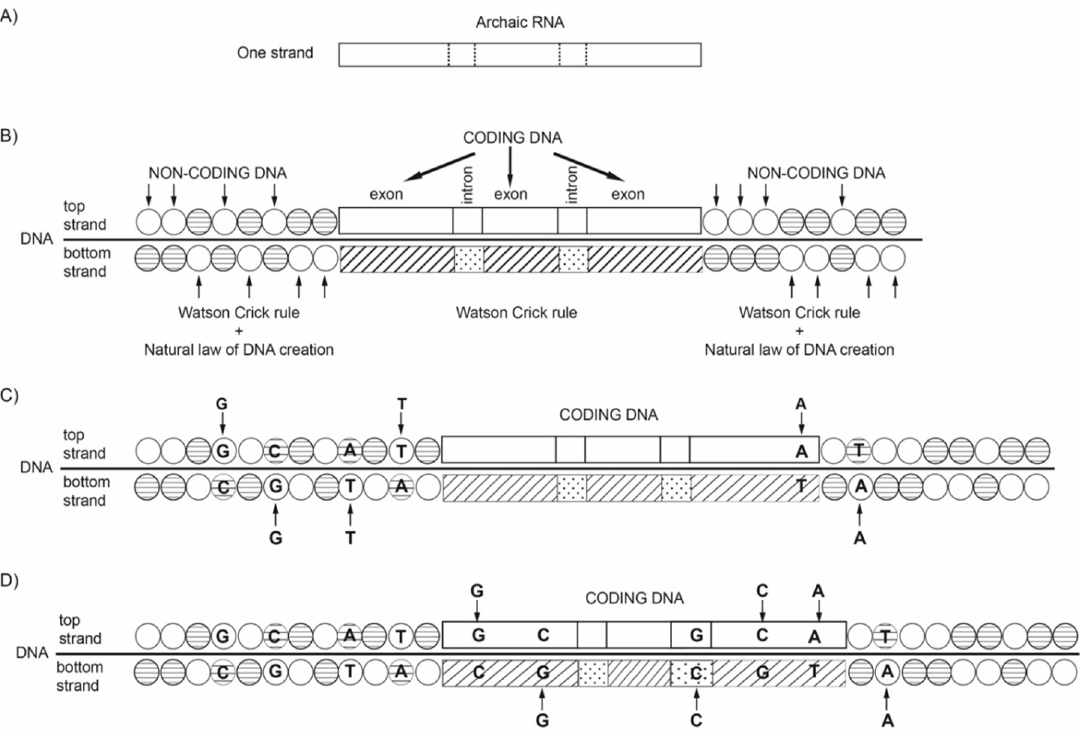
Figure 6. Novel hypothesis of DNA creation. ( A ) Single strand archaic RNA, being short, fragile and without symmetries and with the absence of CSPR, had limited evolutionary potential. ( B ) Double-stranded DNA originated by binding archaic RNA with its complementary nucleotides, creating pairs A → T, C → G according to the Watson Crick rule, giving rise to the double helix of coding DNA. It was initially also symmetry-free, with the absence of CSPR. Simultaneously, besides the Watson–Crick rule, there appeared a new insertion of nucleotides according to the natural symmetry law of DNA creation and conservation; the same nucleotides entered both strands, regardless of localization. This led to the creation of noncoding DNA with quadruplet mirror symmetries. ( C ) As a result of the new principle of creation based on the natural symmetry law of DNA creation and conservation, noncoding DNA grows much faster, and thus, the new insertions are induced. If an additional insertion enters a segment on one strand of coding DNA, it contributes to its enlargement but without creating new symmetries. On the other hand, the same insertion into the long noncoding part of the DNA does not essentially violate its symmetries. ( D ) Insertion into one strand of an exon, and according to the natural symmetry law of DNA creation and conservation, the accompanying insertion into the opposite strand but in the position of an intron does not create symmetries and CSPR for coding DNA. If the same insertions enter both strands of the exon, they do not lead to symmetries and CSPR because they do not compensate symmetry-free archaic DNA built into the DNA molecule. In summary, insertions, as rare events, cannot violate symmetries in large noncoding DNA because of the natural symmetry law of DNA creation and conservation, and insertions (mutations) in much smaller coding DNA cannot create symmetries because of built-in symmetry-free archaic RNA. However, viewing the whole DNA molecule, regardless of whether an insertion enters the coding or noncoding part, due to the natural symmetry law of DNA creation and conservation, the same insertions always enter both strands, and thus, its growth fully supports CSPR. In this way, quadruplets, as basic building elements with mirror symmetries, gave the DNA molecule strong evolutionary